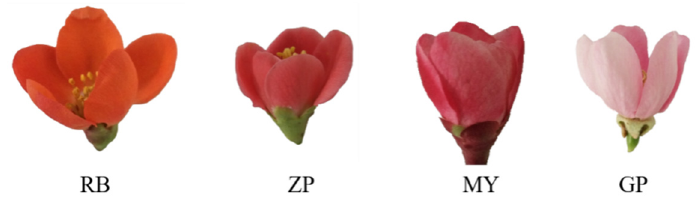
Figure 1. Petal colors of the four Chaenomeles plants. Chaenomeles japonica (RB), Chaenomeles speciose (ZP), Chaenomeles sinensis (GP), and Chaenomeles cathayensis (MY).